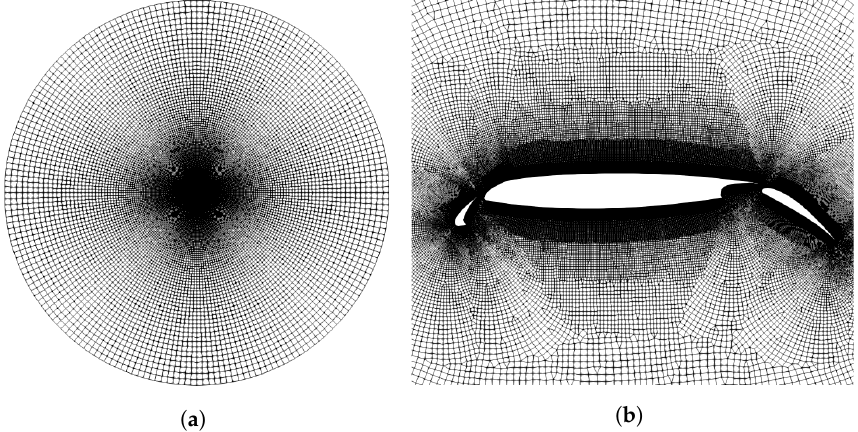
Figure 10. Mesh for the high-lift aerofoil configuration, along with slat and flap. ( a ) Far-field view. ( b ) Close-up view.